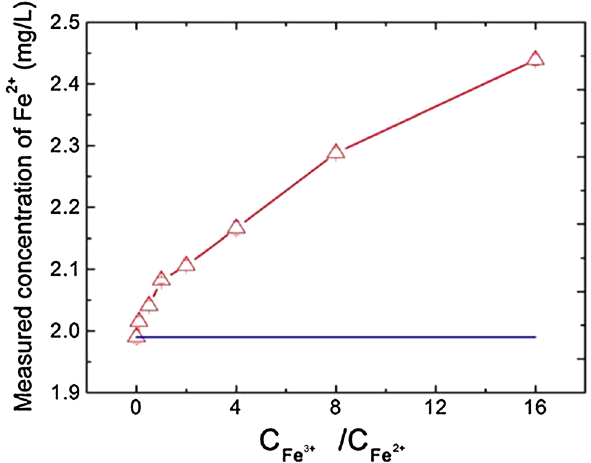
Fig. 1 Interference of Fe 3+ on the measured concentration of Fe 2+ . C Fe 3+ /C Fe 2+ was molar concentration ratio. Experimental conditions: 2 mg/L Fe 2+ and different concentrations of Fe 3+